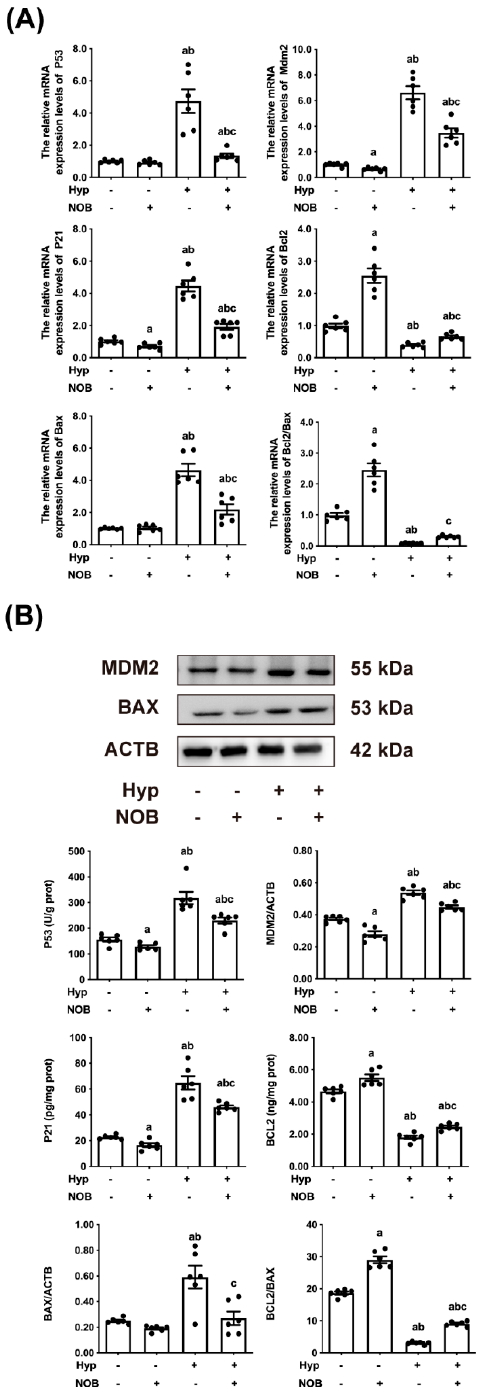
Figure 3. NOB modulated placental P53 pathway and mitochondrial apoptosis pathway in RUPP rats. ( A ) The mRNA expressions of P53, Mdm2, P21, Bcl2, and Bax were estimated using an RT-qPCR. The mRNA ratio of Bcl2/Bax was calculated. ACTB was used as an internal control. ( B ) The protein expressions of P53, P21, and BCL2 were detected using the rat P53 ELISA kit, rat P21 ELISA kit, and rat BCL2 ELISA kit, respectively. The MDM2 and BAX protein levels were estimated using a Western blot. ACTB was used as an internal control, and the relative protein expression was the ratio of the target protein to ACTB. Data are expressed as the mean ± standard error (Mean ± SEM). a: comparing with the control groups, p < 0.05; b: comparing with the NOB groups, p < 0.05; c: comparing with the hypoxia groups, p < 0.05.